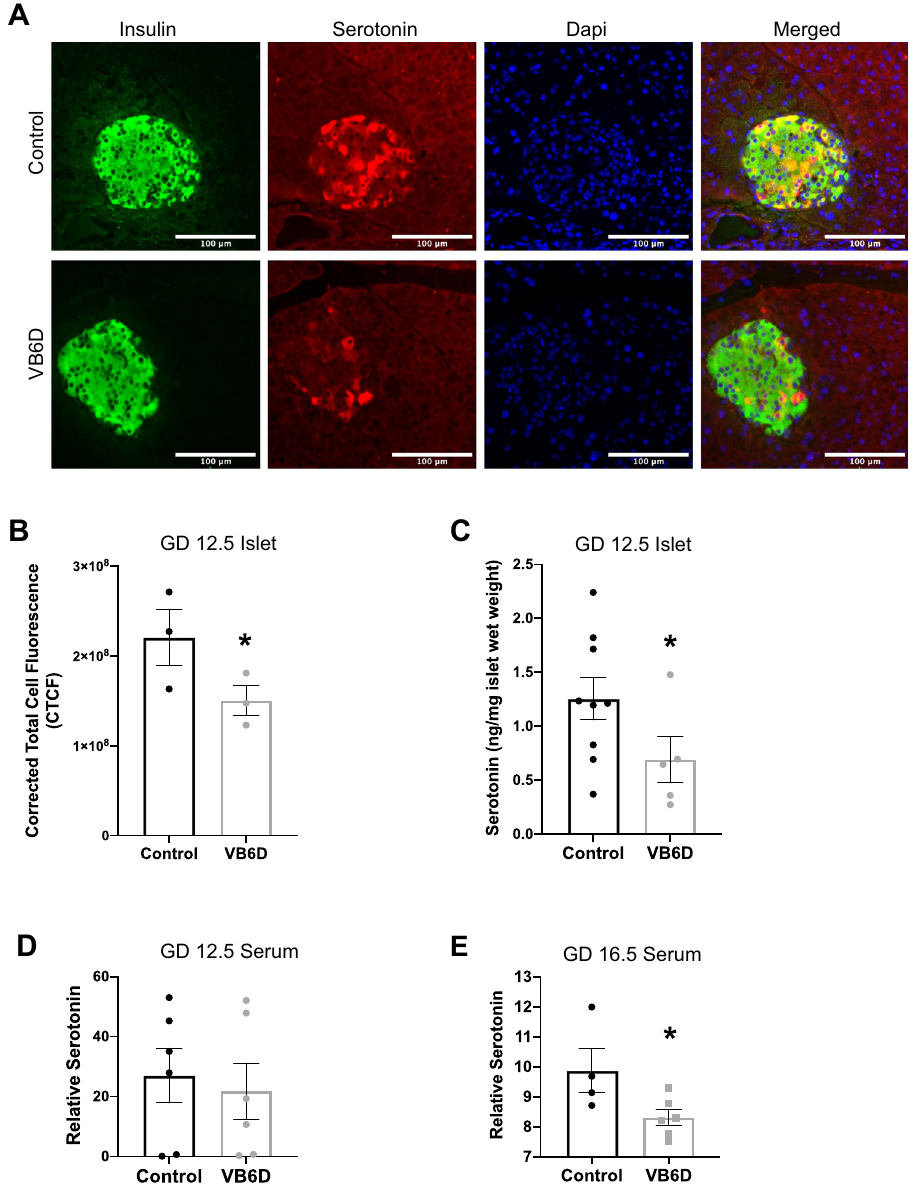
Fig. 3 Reduced islet and serum serotonin in vitamin B6-de fi cient dams at GD 12.5 and 16.5, respectively. Representative ×20 immuno fl uorescent images of GD 12.5 pancreases from control and vitamin B6-de fi cient or VB6D dams ( A ). Corrected total cell fl uorescence (CTCF) was used to calculate islet serotonin in the GD 12.5 pancreases ( B ). In ( C ), we used LC-HRMS to measure absolute islet serotonin levels. Relative serum serotonin levels in GD 12.5 ( D ) and 16.5 ( E ) control and VB6D dams were measured using LC-MS. We analyzed 40 – 50 islets per mouse ( N = 3 mice) in panels ( A ) and ( B ), 6 – 10 mice in panel ( C ), and 5 – 7 mice in panels ( D ) and ( E ). Unpaired, one-sided, t -tests were performed in ( B – E ). * p ≤ 0.05; non-signi fi cant (ns) represents p values > GD12.5 vitamin B6-de fi cient dams remained glucose intolerant compared to agonist-treated controls dams ( p = 0.0290; the agonist group in Supplemental Fig. 6d and triangle symbol in Supplemental Fig. 6c). In contrast, at GD 16.5, the HTR2B agonist treatment ameliorated the glucose-intolerant phenotype in vitamin B6-de fi cient mice compared to PBS-treated vitamin B6-de fi cient dams ( p = 0.0185; gray bars in Fig. 4C and gray time graphs in Supplemental Fig. 7c). Collectively, our results demonstrate that vitamin B6 de fi ciency-induced glucose intol- erance is mediated through HTR2B-dependent disruption of serotonin signaling, and intervention with an HTR2B agonist restores β -cell proliferation at GD 12.5, but the improvement in glucose tolerance is not observed until GD 16.5.